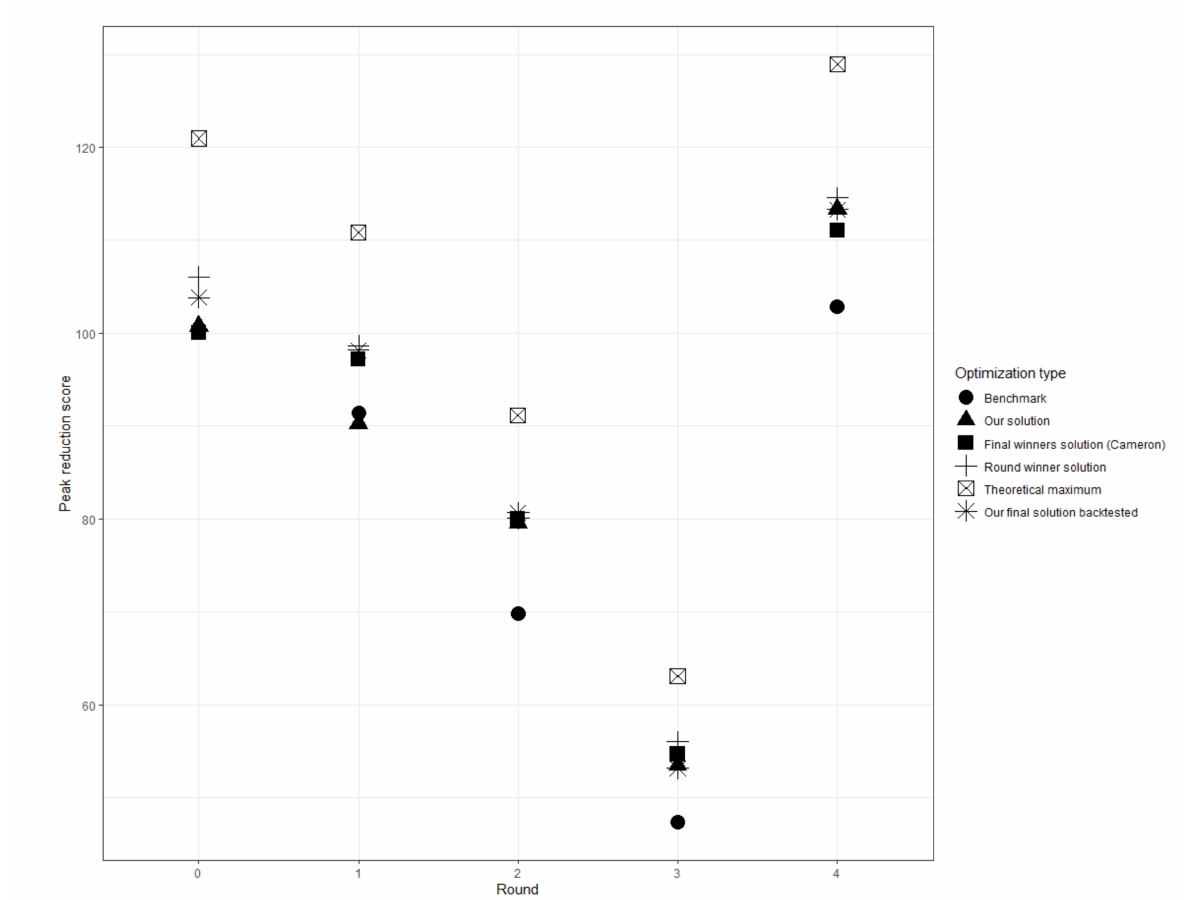
Figure 5. Peak reduction scores of our solution, the benchmark, and the competitors’ solutions in the 4 + 1 rounds. Rounds 3 and 4 correspond to Christmas and COVID lockdown periods,